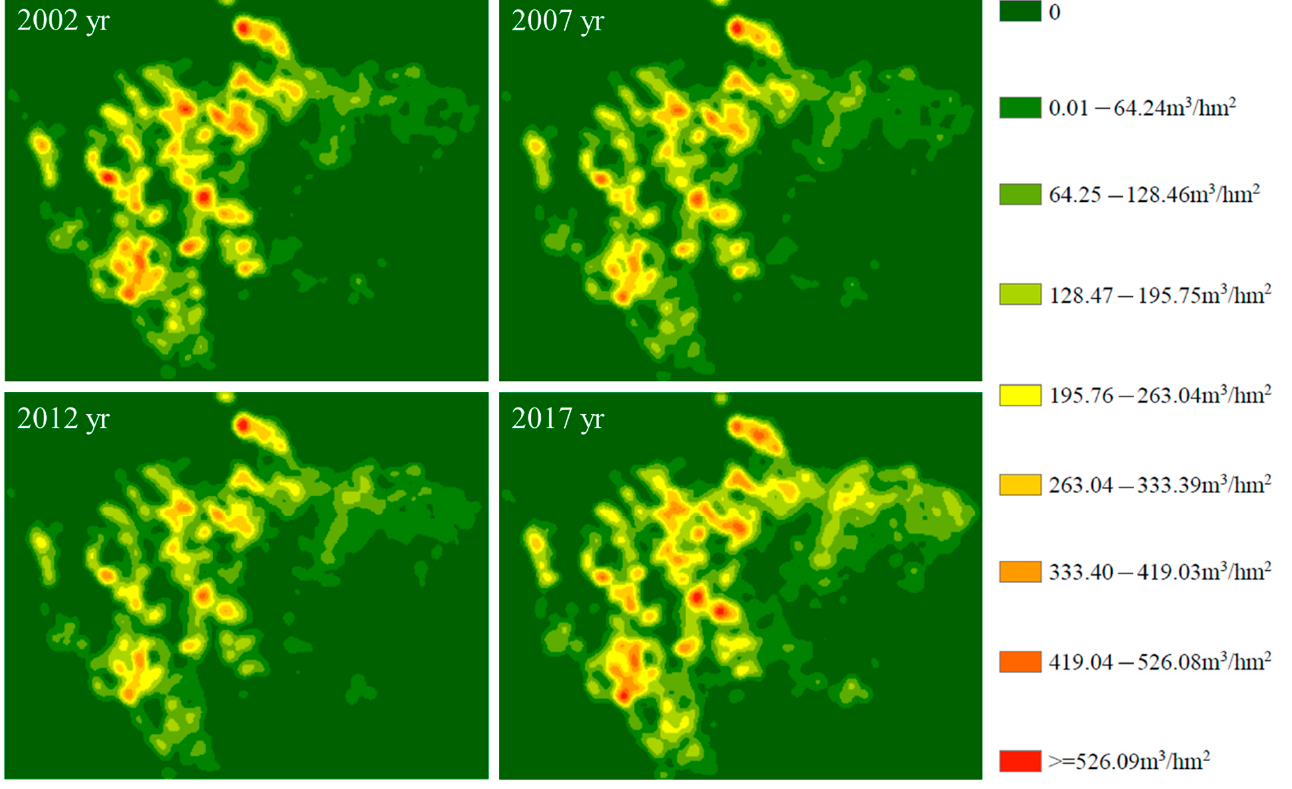
Figure 3. Heat map of the forest biomass